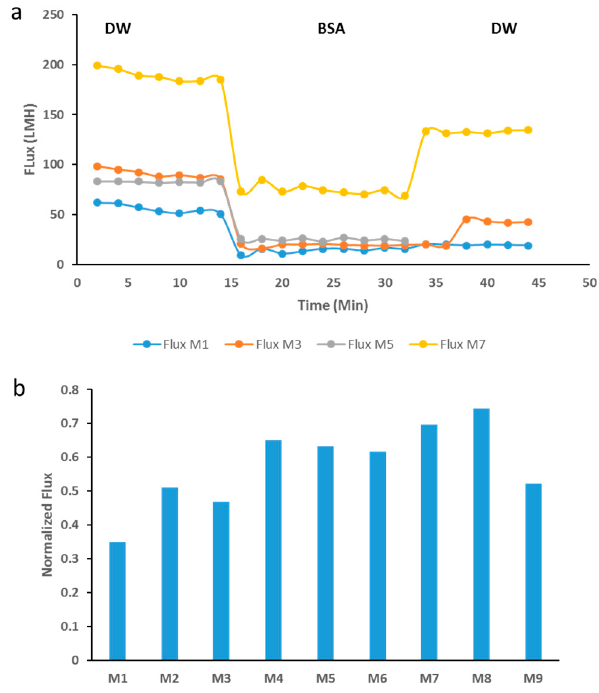
Figure 10. BSA (bovine serum albumin) fouling test with different membrane samples ( a ) The DW (deionized water) flux was measured for the first 15 min of filtration, then DW was replaced with BSA solution and the flux was evaluated for the next 15 min, after which time the flux for DW filtration was measured for the last 15 min. ( b ) Normalized flux for different PES membranes, calculated as the J f / J 0 ratio, after filtration of BSA solution.